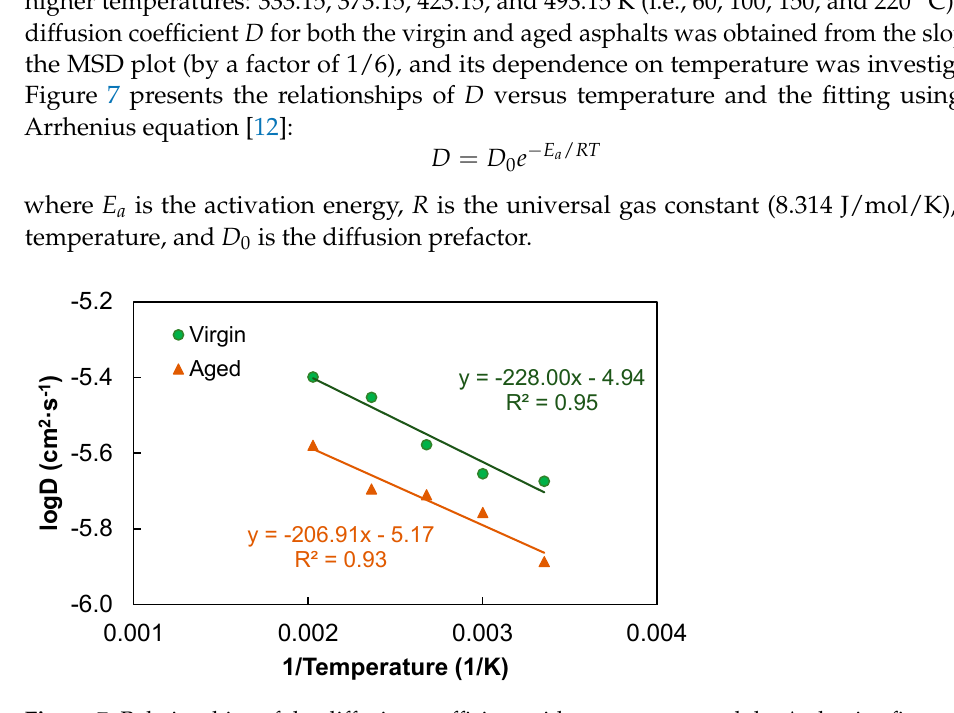
Figure 7. Relationships of the diffusion coefficient with temperature and the Arrhenius fits.